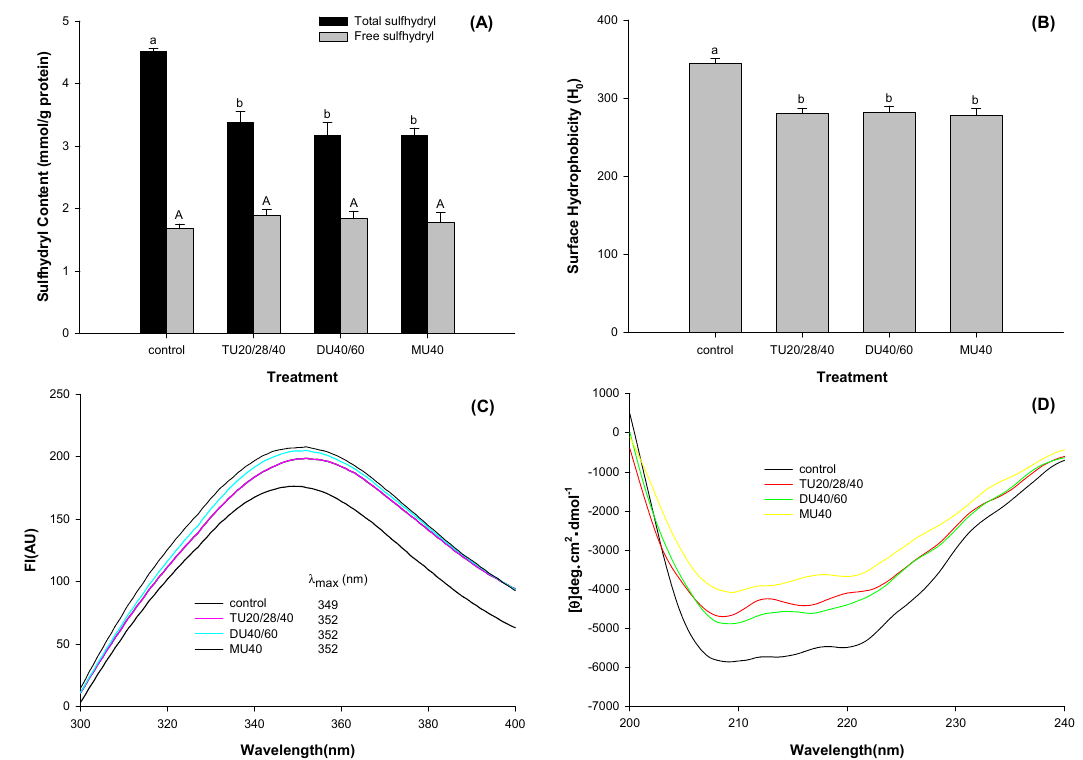
Figure 4. Effects of online-US/T40/pHS treatment at the frequency of TU20/28/40, DU40/60, and MU40 kHz on sulfhydryl content ( A ), surface hydrophobicity ( B ), intrinsic fluorescence ( C ), and circular dichroism ( D ) of potato protein. Means with different letters (a–b or A–B) differ significantly ( p < 0.05).